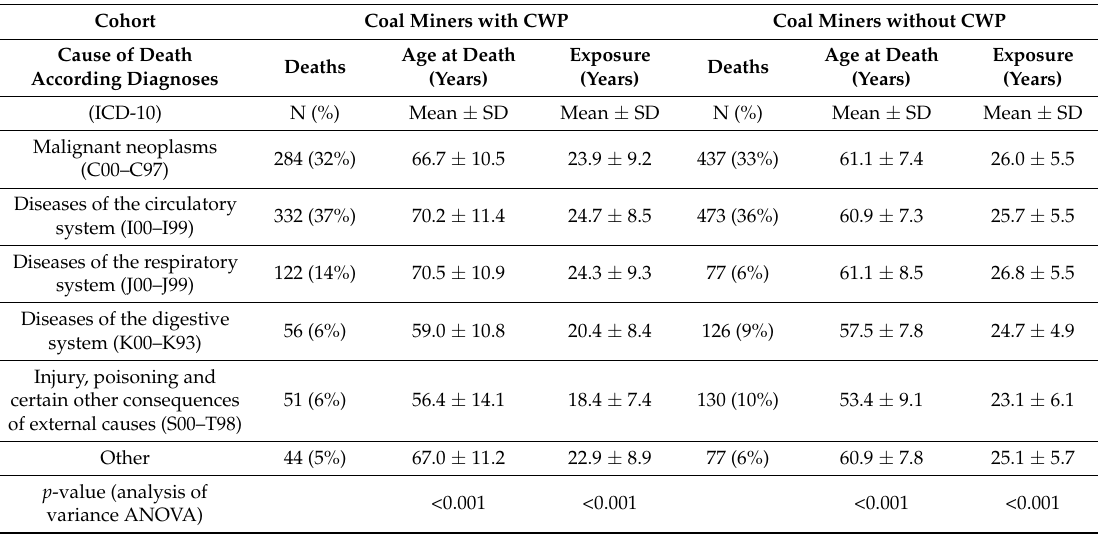
Table 2. The causes of death in the cohorts of coal miners with and without coal-workers´ pneumoconiosis